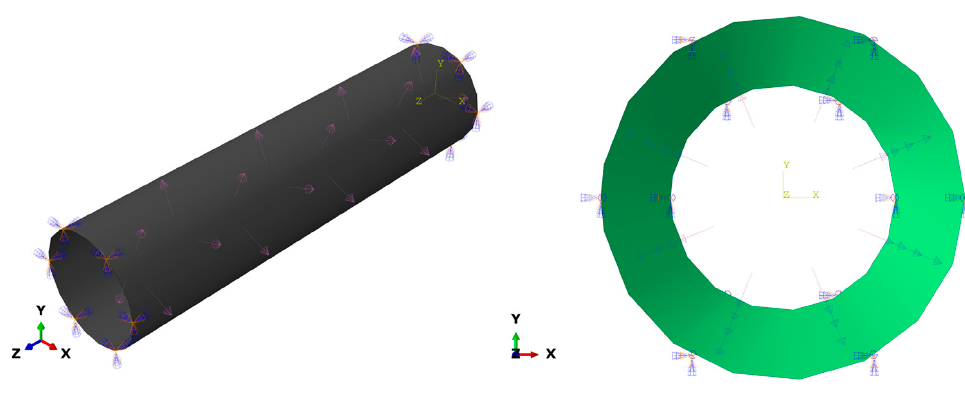
Figure 3. GFRP composite pipe subjected to hydrostatic internal pressure. Table 3. The ply properties of GFRP composite being used [11,56].